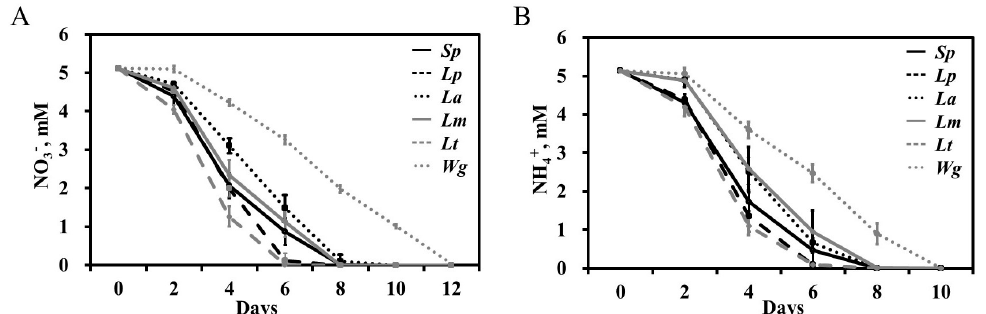
Figure 2. Dynamics of N uptake by six duckweed species grown in medium supplied with 5 mM NO (cid:2871)(cid:2879) ( A ) or NH (cid:2872)(cid:2878) ( B ). The y ‐ axis shows the concentration of NO (cid:2871)(cid:2879) or NH (cid:2872)(cid:2878) remaining in the medium. Sp , S. polyrhiza (NB5548); Lp , L. punctata (NB0031); La , L. aequinoctialis (NB0007); Lm , L. minor (NB0020); Lt , L. turionifera (NB0013); Wg , W. globosa (NB0015). When grown in medium supplied with both NH (cid:2872)(cid:2878) and NO (cid:2871)(cid:2879) , the most common situation in the natural environment, all duckweed species demonstrated a clear preference for NH (cid:2872)(cid:2878) , with three species ( S. polyrhiza , L. punctata , and L. turionifera ) consuming almost all of the available NH (cid:2872)(cid:2878) during the first four days of cultivation (Figure 3). The duckweeds started to utilize NO (cid:2871)(cid:2879) only when the concentration of NH (cid:2872)(cid:2878) dropped below 0.5 mg/L (0.04 mM).